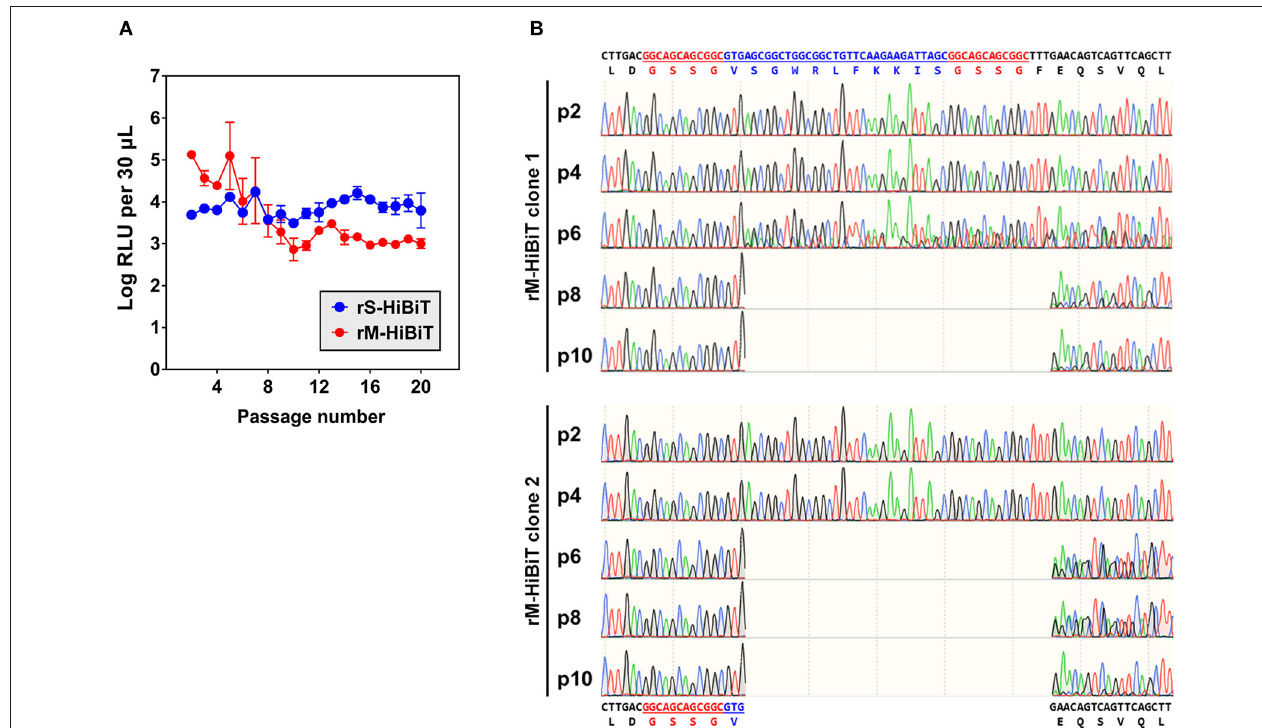
FIGURE 4 | Genetic stability of HiBiT-tagged rIBVs. (A) Expression of HiBiT-tagged proteins in passaged rIBVs. The rS-HiBiT and rM-HiBiT were serially passaged at MOI ∼ 0.1 in Vero cells for 20 times. Two clones were used for each virus. For each passage, cell lysate samples were subjected to luminescent analysis as in 3C and luminescent intensities were expressed in the unit of log RLU per 30 µ L. The average values and standard deviations of the two clones were shown. (B) Genetic instability of rM-HiBiT during its passaged in Vero cells. The total RNA of Vero cells infected with rM-HiBiT clone 1 and clone 2 in passage 2, 4, 6, 8, and 10 in (A) were extracted and the IBV M gene was amplified by RT-PCR and sequenced. The nucleotide and amino acid sequences of the original HiBiT-M protein and its truncated mutant were shown on the top and at the bottom, respectively. The GSSG linkers were in red and the HiBiT tag was in